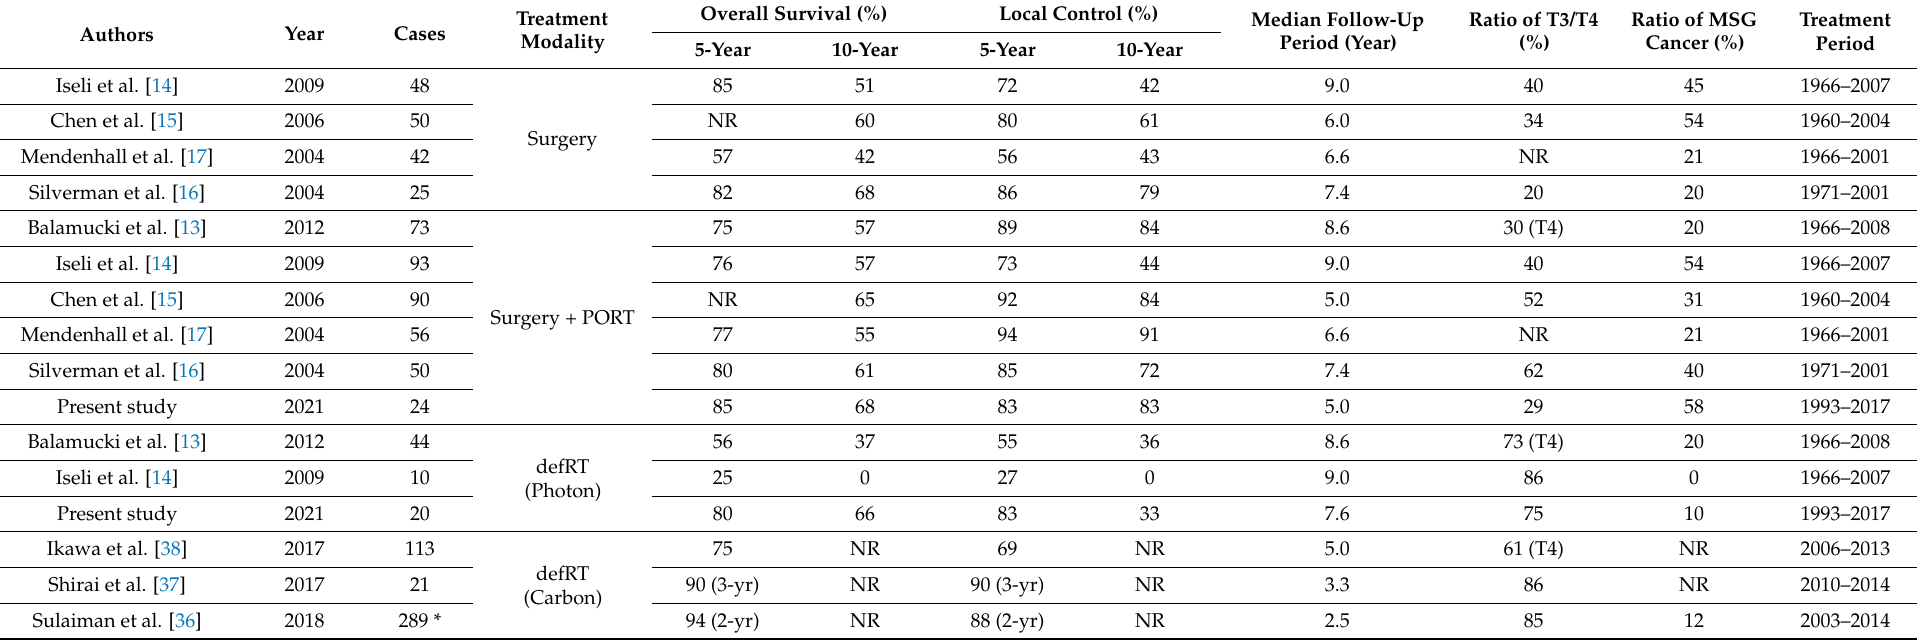
Table 5. Comparison of treatment